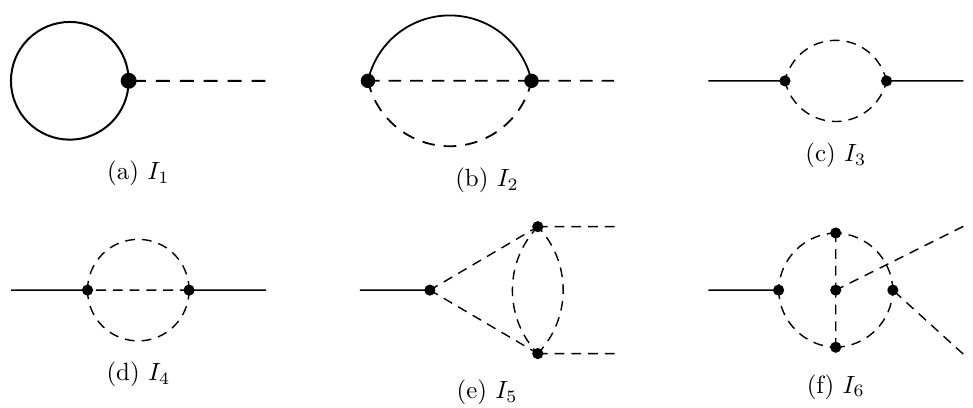
Figure 4. Topologies of boundary integrals. Solid and dashed lines correspond to massive and massless particles respectively. See appendix B for their explicit expressions.